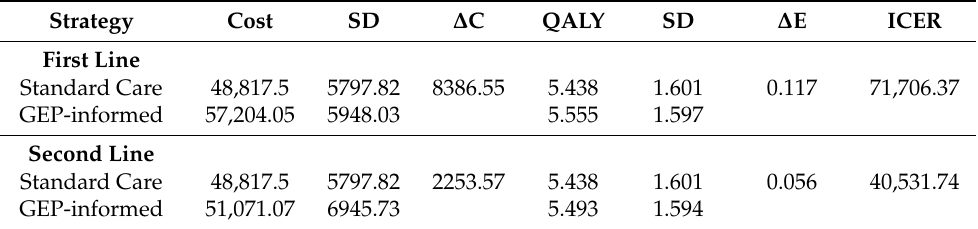
Table 4. Cost effectiveness results at varying assumptions of reductions in disease recurrence, baseline analysis.